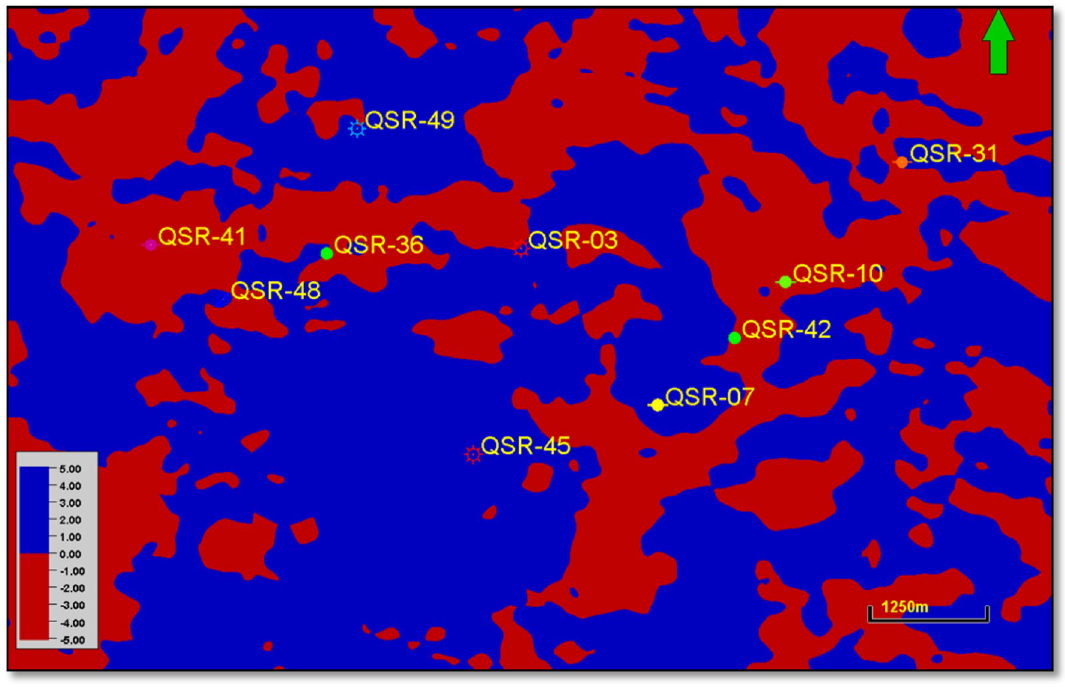
Fig. 17 Seismic horizontal section (time slice) at − 1995 ms. Note the positive amplitude is displayed in blue color, while negative amplitude is displayed in red